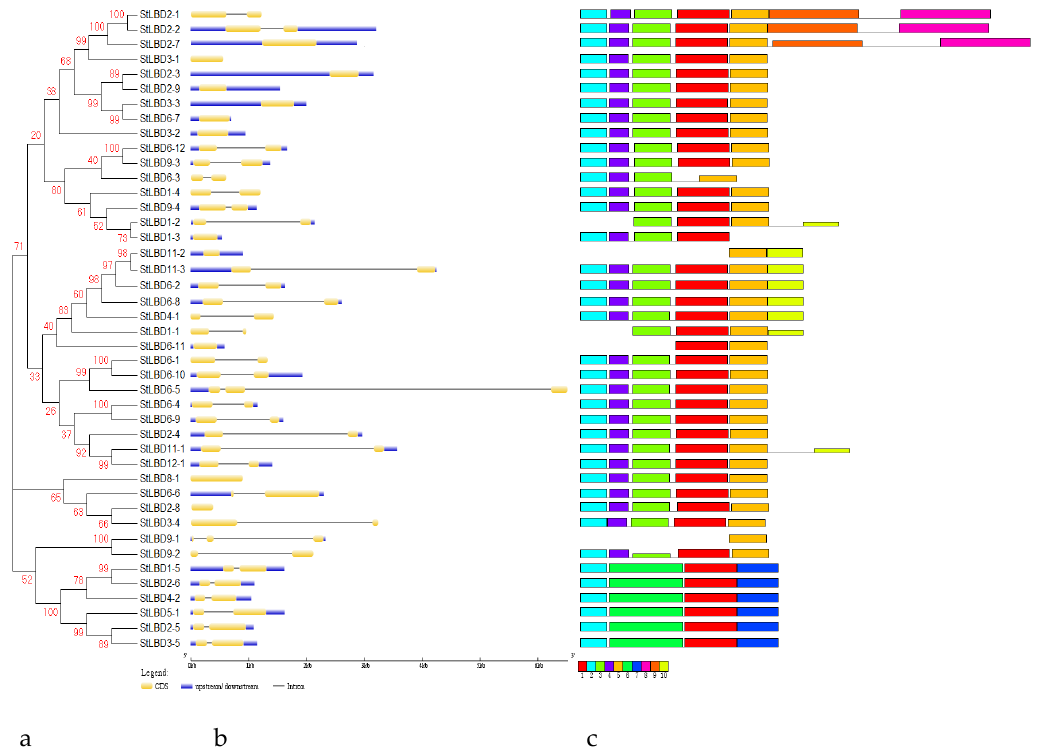
Figure 3. Phylogenetic relationships of the potato LBD gene family ( a ), gene structure ( b ) and conserved domain ( c ). The potato LBD amino acid sequence was aligned by Clustal X 1.83. The phylogenetic tree was constructed using the N-J method of MEGA7. Bootstrap verification produced 1000 duplicate bootstrap values. These genomic sequences corresponding to their cod sequences (CDS) were predicted online using GSDS (http://gsds.cbi.pku.edu.cn) to detect the intron/exon distribution of the corresponding StLBD gene. The yellow boxes indicate the cod sequences (CDS). The discontinuous lines indicate the introns of these genes. The right side represents the motif composition associated with each StLBD protein. The motifs, numbered 1-10, are displayed in different colored boxes.